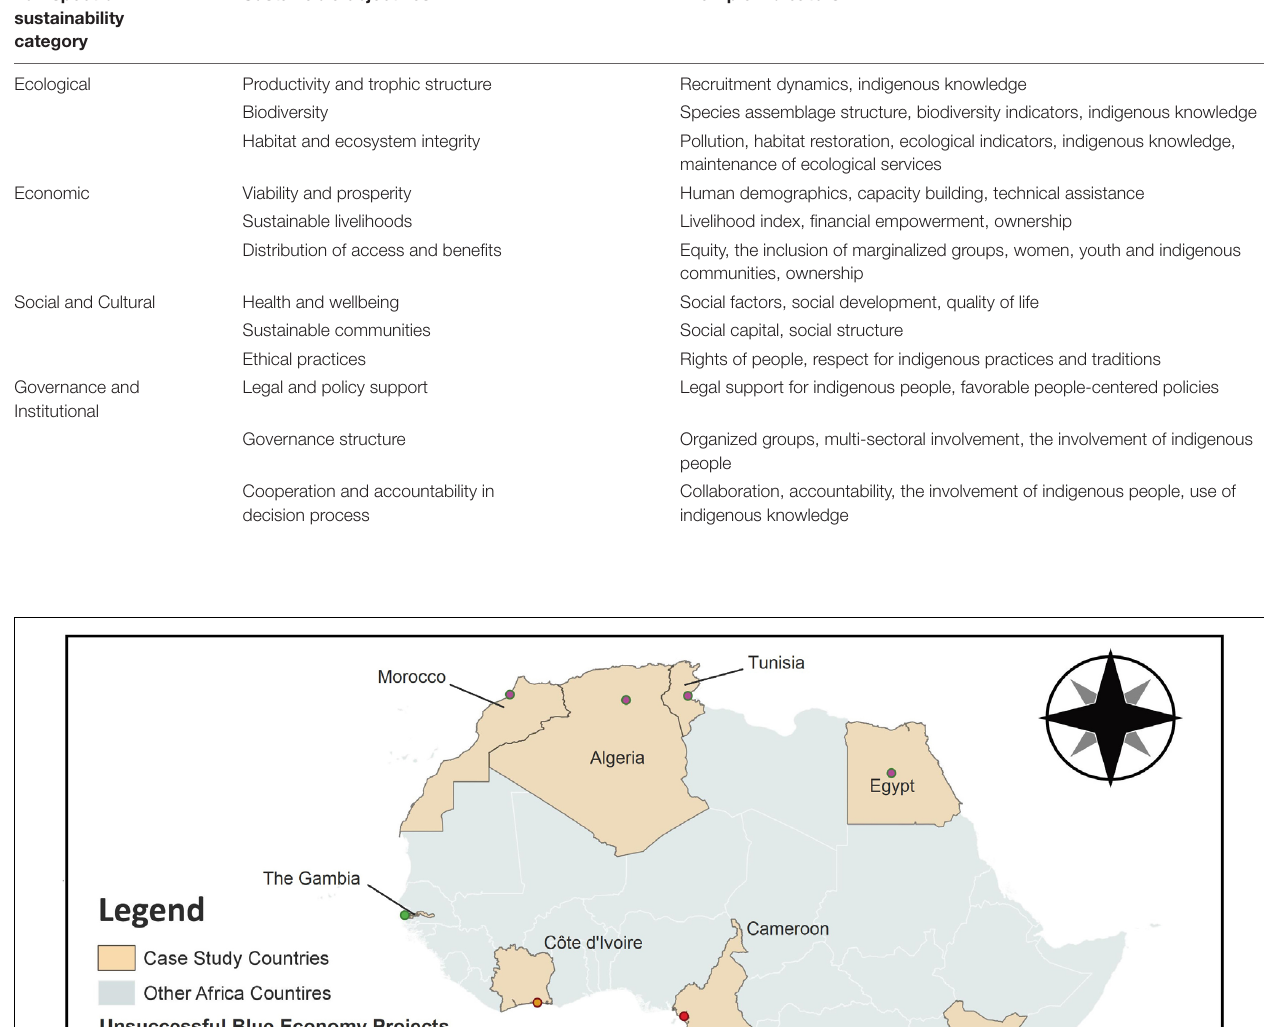
TABLE 1 | Summary of full spectrum sustainability (FSS) for assessment of BE activities in Africa, adapted from Jones and Stephenson (2019). Full-spectrum sustainability